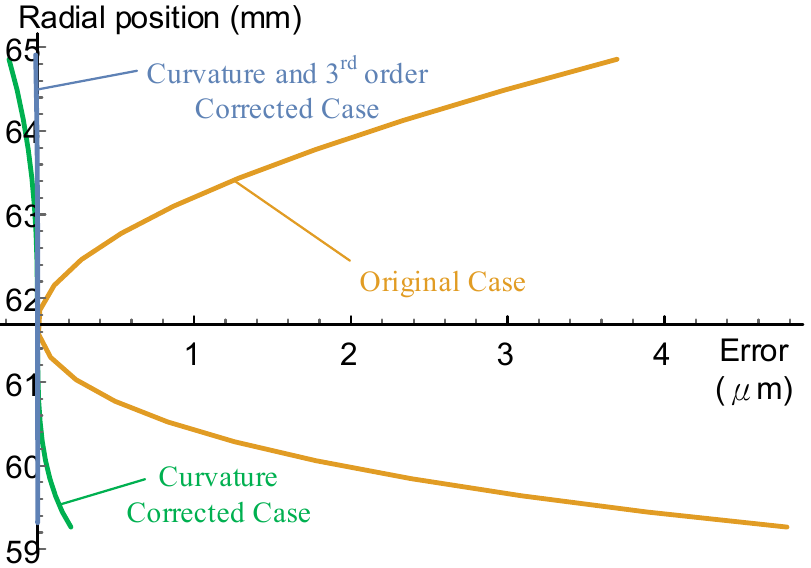
Figure 13. Comparison of the correction model of the cutter face step by step, with ξ = 0. The result of the corrected case of the major cutter face approaches zero. To verify the effects of the proposed correcting model on other resharpened cutter faces with positive profile shifting, the results of the corrected and noncorrected cases with the cutter faces ξ = 5 and ξ = 2.5 are shown in Figures 14 and 15, respectively. As the results show, after correction, the cutter edges of the shaping cutter perform more accurately in terms of the pressure angle error and form error for positive profile shifting